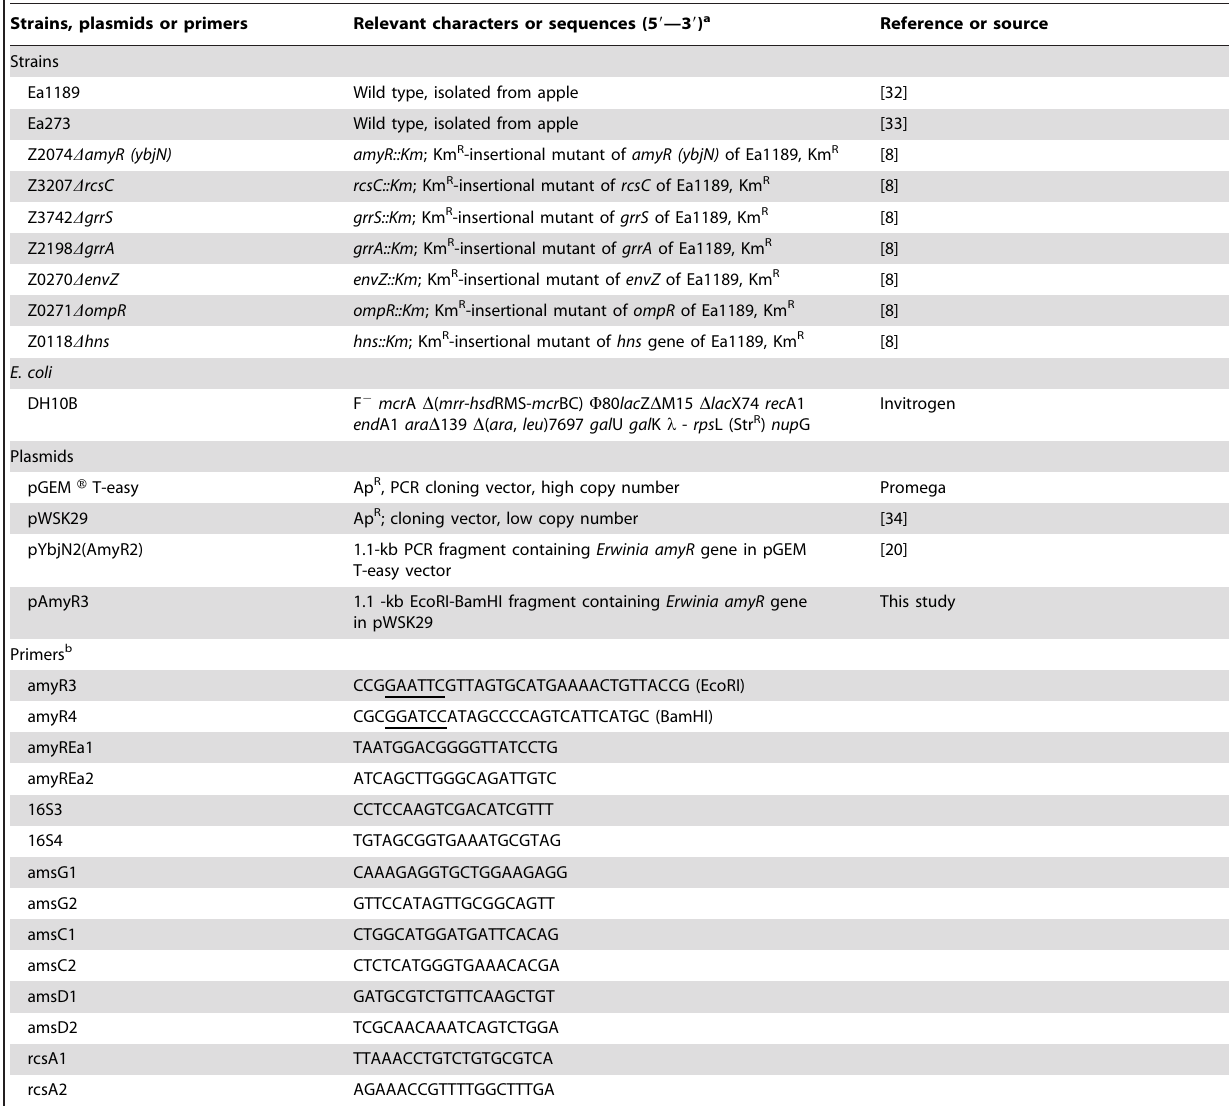
Strains, plasmids or primers Relevant characters or sequences (5 9 —3 9 )